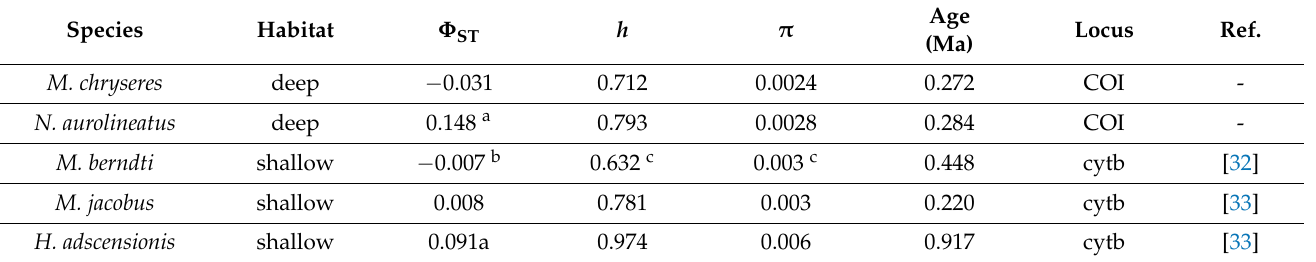
Overview of phylogeographic comparisons among holocentrid species ( h = haplotype diversity, π = nucleotide